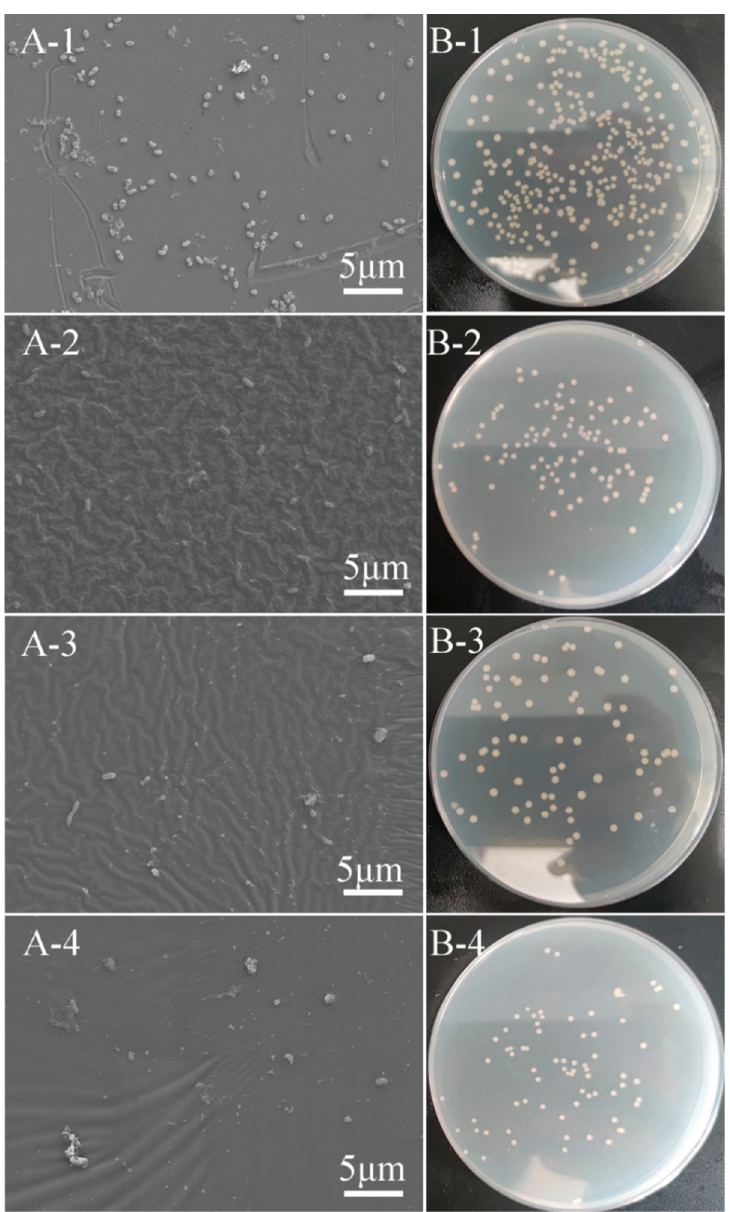
Figure 8. FE-SEM images ( A ) and plate counting ( B ) after the antifouling test; -1: 304 stainless steel, -2: PCSi1, -3: PCSi3, and -4: PCSi5.